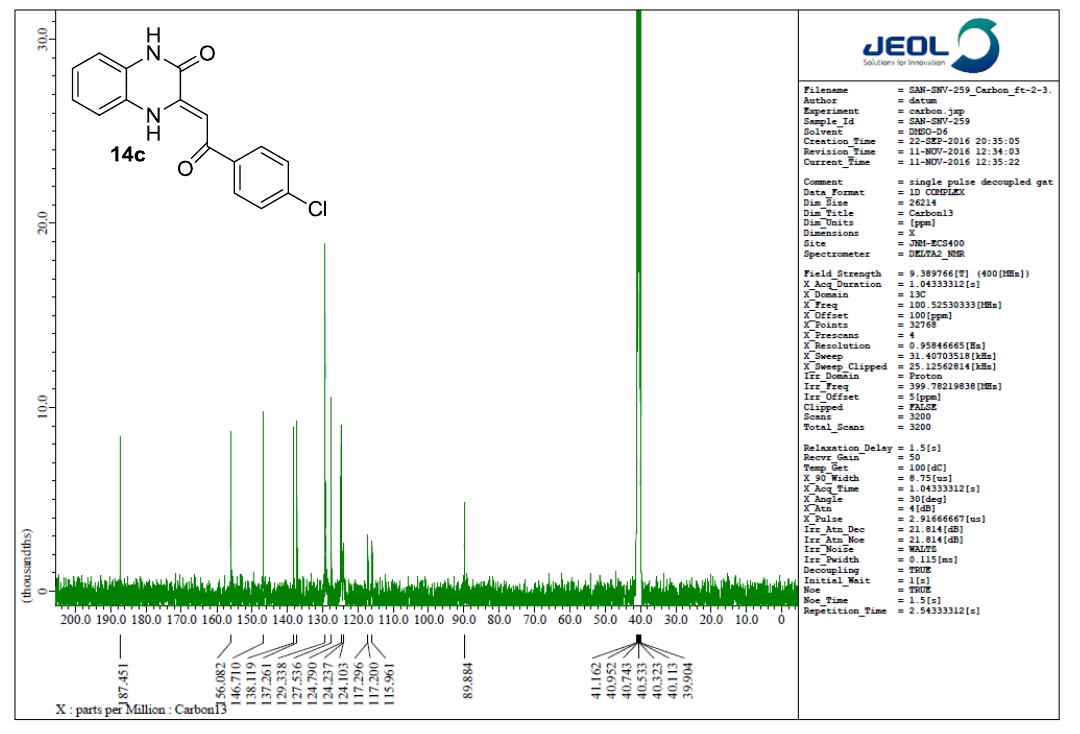
Figure 34 . 13 C NMR Spectra of Compound 14c